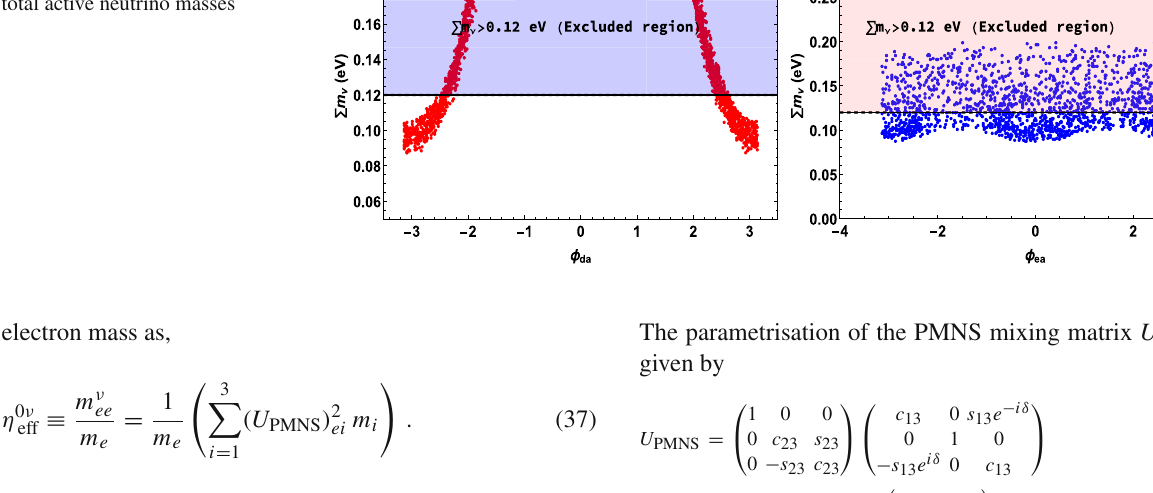
Fig. 7 Left (Right) panel shows the variation of φ da ( φ ea ) with total active neutrino